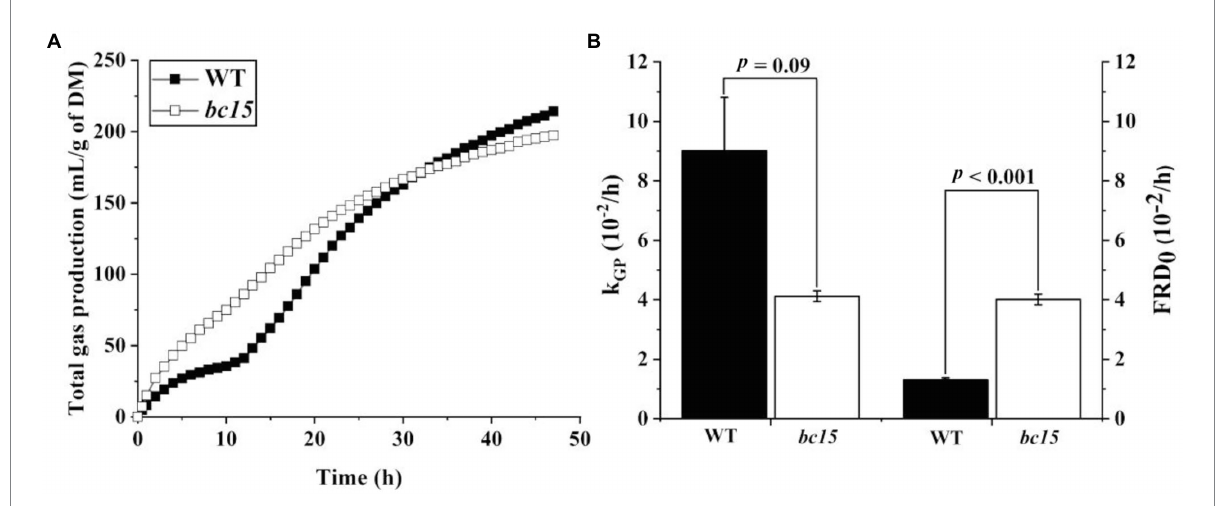
FIGURE 1 The kinetics of ruminal gas production (A) and its fractional rate of gas production (k GP , 10 − 2 /h) and initial fractional rate of degradation at 0 h ( B , FRD 0 , 10 − 2 /h) of wild-type (WT) and brittle culm 15 ( bc15 ) mutant rice straws after 48-h in vitro ruminal incubation ( n = 3). Data with error bars are expressed as mean ± standard